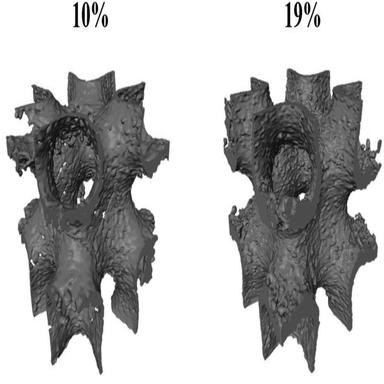
Reconstructions of CT scan images of unit cells taken from the center of 10% and 19% relative density samples.